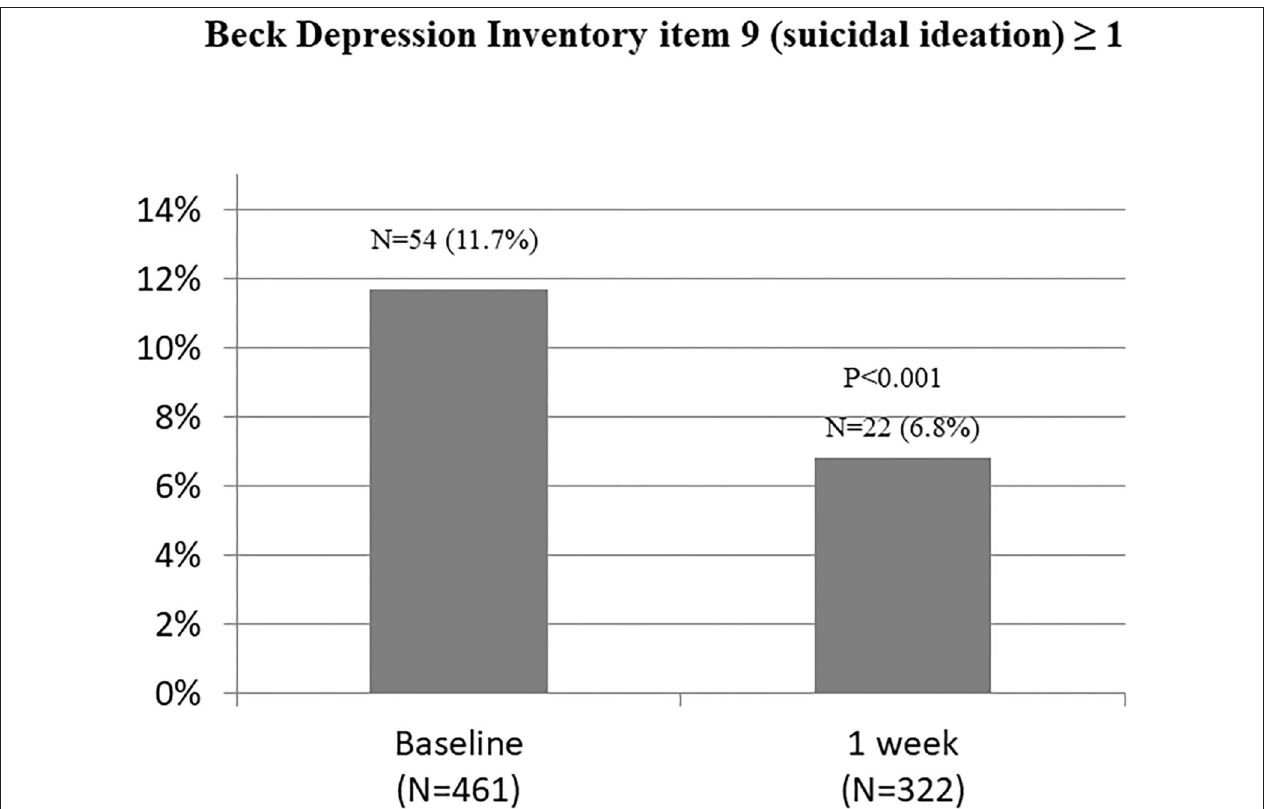
FIGURE 3 | Changes in suicidal ideation from baseline to 1